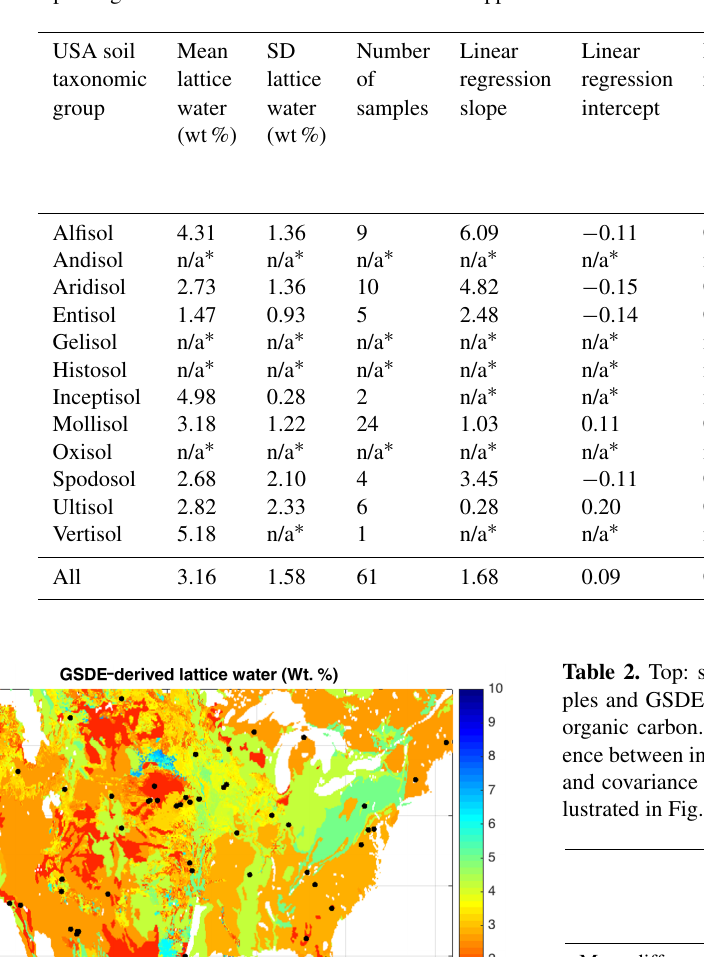
Table 1. Summary of mean and standard deviation of in situ lattice water samples organized by US soil taxonomic groups. The table also summarizes a linear regression analysis using the GSDE clay percent and in situ samples. The last column indicates how the 1km CONUS lattice water map was generated. ∗ Note that n/a stands for not applicable because of a lack of data.